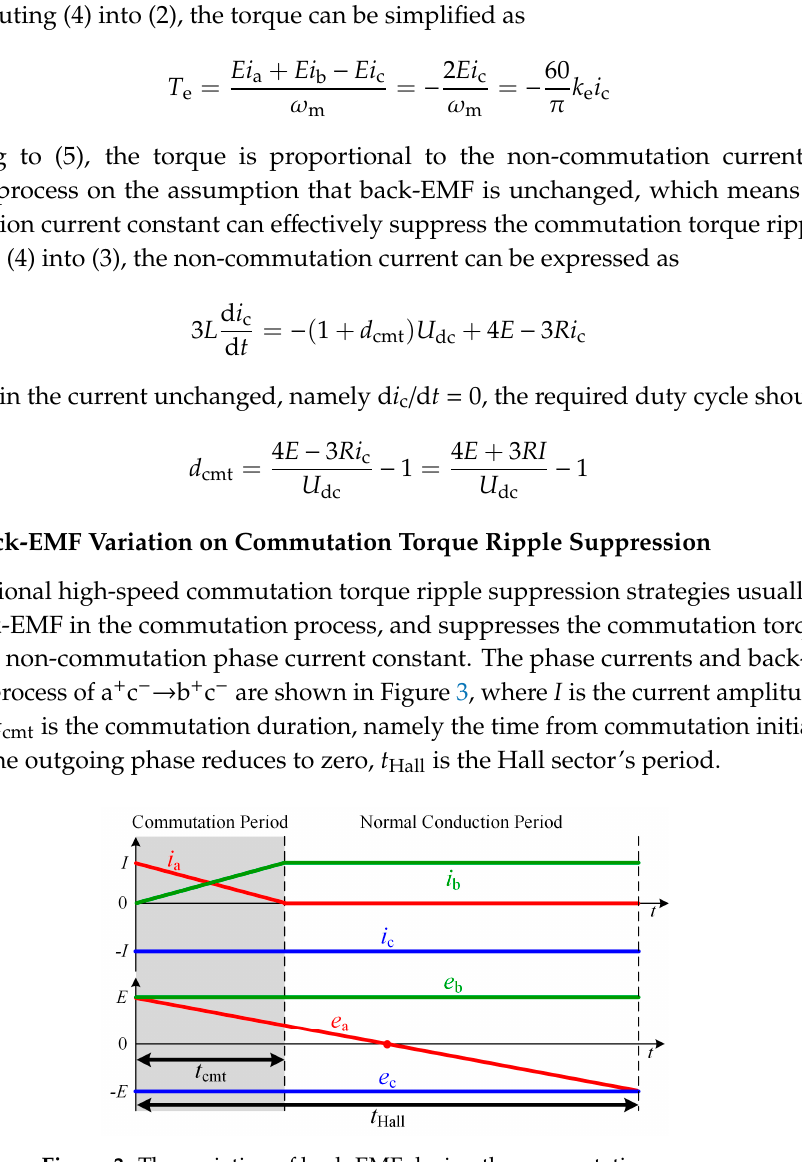
Figure 3. The variation of back-EMF during the commutation process.